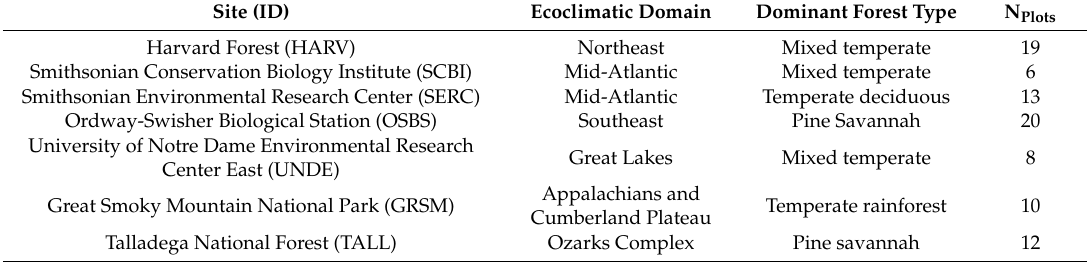
Table 1. Seven forested National Ecological Observatory Network sites measured using both terrestrial laser scanning (TLS) and aerial laser scanning (ALS).